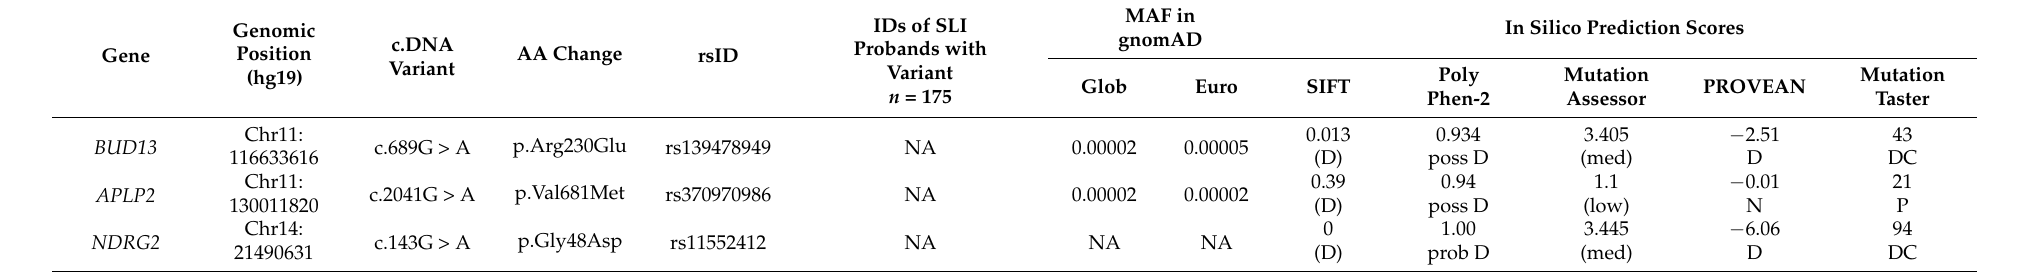
Table 2. Summary of rare variants co-segregating in family 489 according to a priori co-segregation